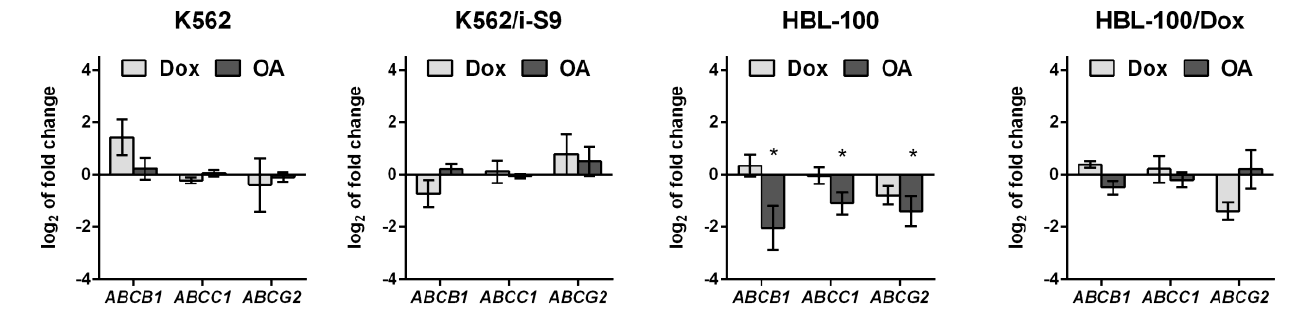
Figure 5. Levels of ABC transporter gene expression (RT-PCR) in K562 and HBL-100 cells and their resistant subclones, K562/iS-9 and HBL-100/Dox cells. The cells were treated with Dox and OA at corresponding IC 50 for 48 h. * Statistical significance of gene expression values as compared to control value ( p < 0.05).